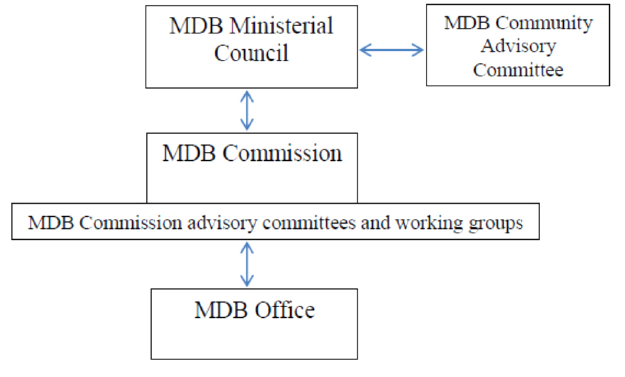
Fig. 2 . The Murray-Darling Basin (MDB) organization under the 1992 Murray-Darling Basin Agreement.